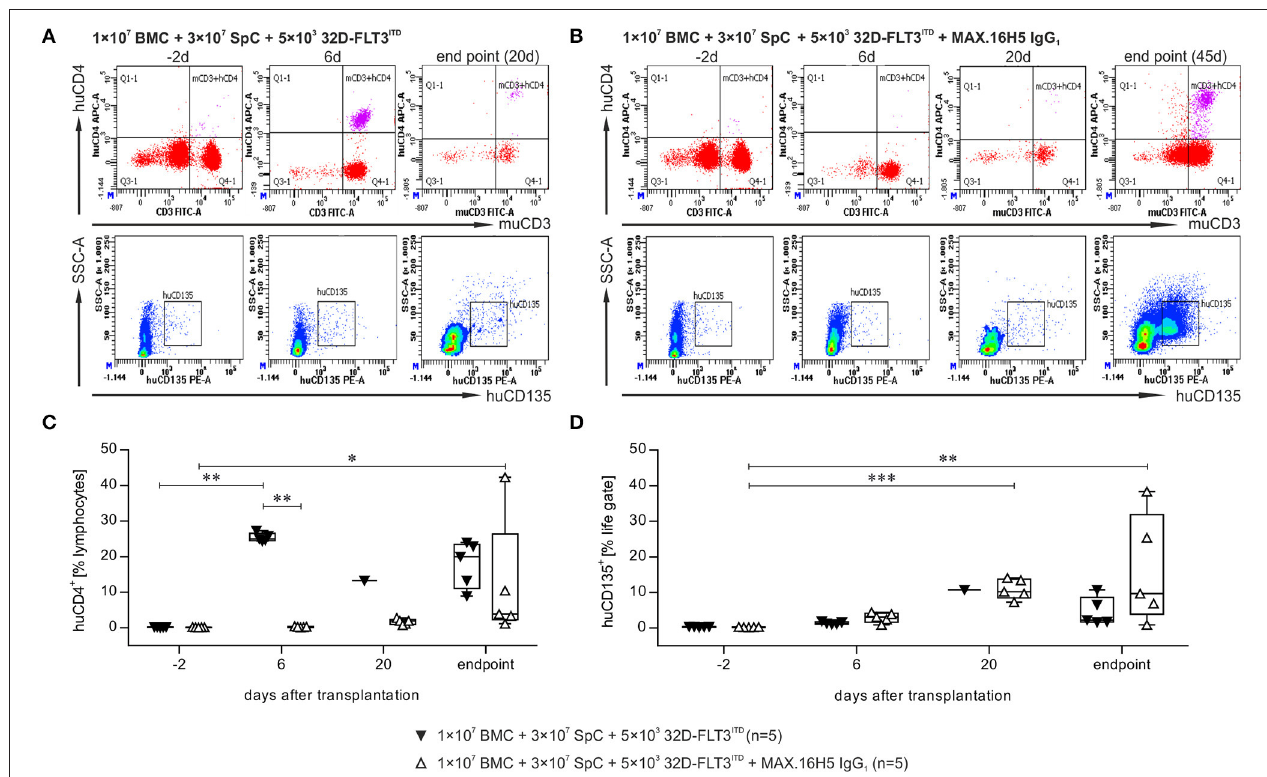
FIGURE 3 | Flow cytometric analysis of the immune reconstitution (murine CD3 + /human CD4 + ) as well as tumor growth (human CD135 + ) after transplantation of bone marrow and spleen cell grafts pre-incubated with MAX.16H5 IgG 1 or without antibody pre-treatment in co-transplantation experiments with 5 × 10 3 32D-FLT3 ITD cells. All recipient animals received 1 × 10 7 bone marrow cells (BMC) and 3 × 10 7 splenocytes (SpC) in these experiments. (A,B) Representative plots of flow cytometric analyses after transplantation of (A) one animal with untreated or (B) one animal with MAX.16H5 IgG 1 pre-treated grafts at different time points [in (A) : day − 2, day 6, endpoint; in (B) : day − 2, day 6, day 20, endpoint] using specific antibodies for murine CD3 + /human CD4 + or human CD135 + . In the lower rows, human CD135 + signals are depicted together with side-scattered light signals. (C) Human CD4 + events as percentages of lymphocyte gates in the blood samples